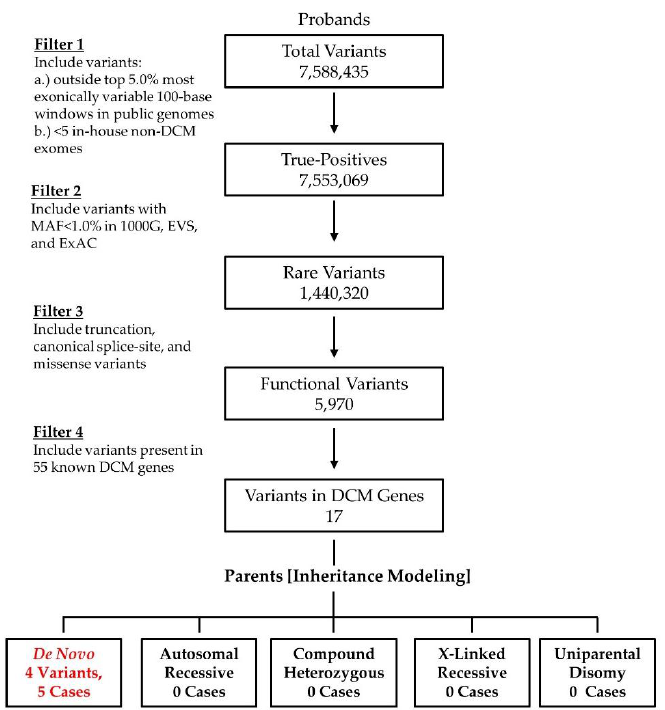
Figure 2. WES filtering scheme in 14 families uncovered five de novo mutations within established DCM genes.